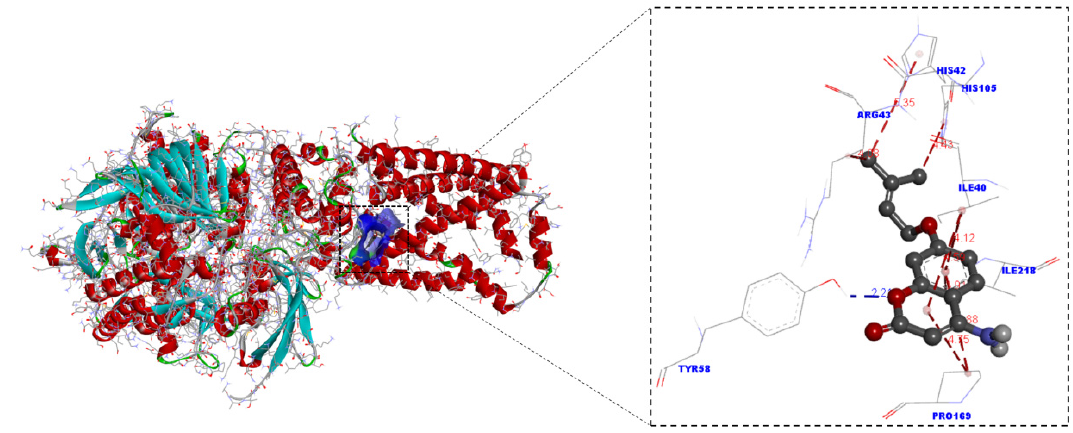
Figure 2. Binding mode and the interaction of inhibitor 3n docking with SDH (PDB code: 1YQ3).